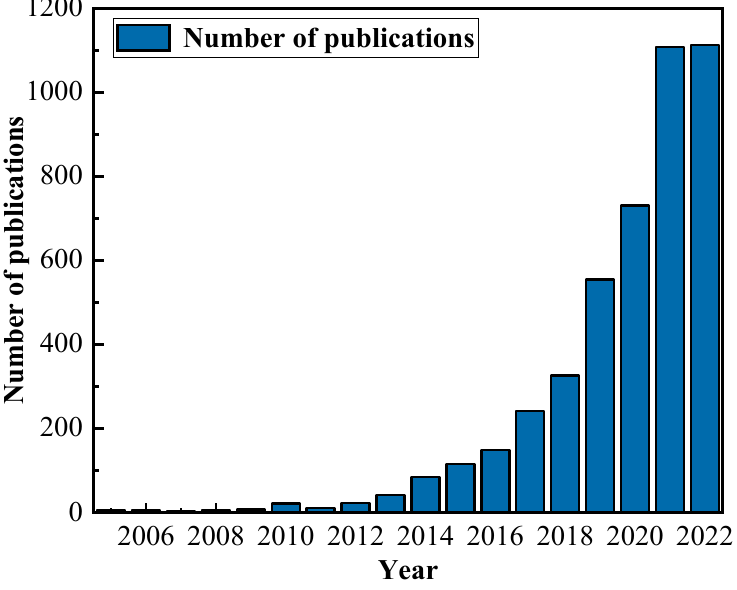
Figure 1. Publication output performance during 2005–2022 (as of December 2022).